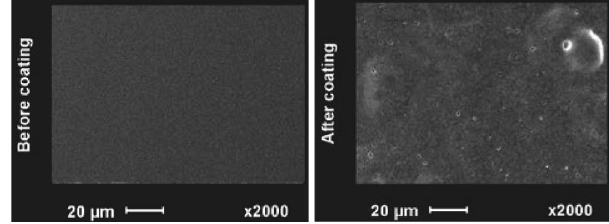
Weise.FIG. 15. Pictures of Nb samples before (left) and after coating (right). Scale (bar 20 μ m) is shown in the lower left